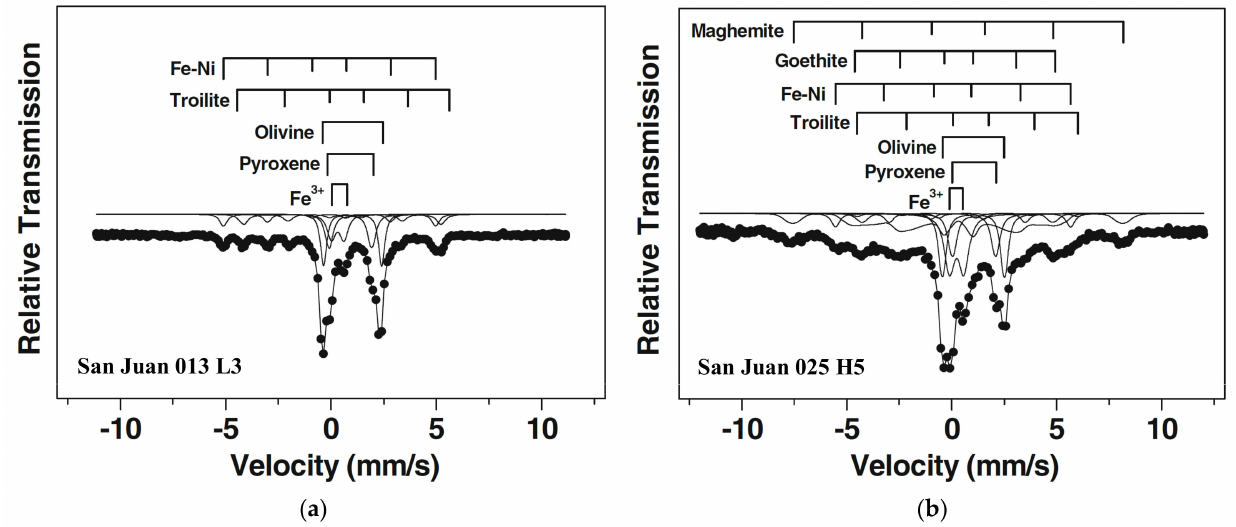
Figure 48. Mössbauer spectra of San Juan 013 L3 ( a ) and San Juan 025 H5 ( b ) ordinary chondrites with different weathering grade found in the Atacama Desert, Chile and measured at room temperature. Indicated components are the results of the spectra decomposition. Adapted from Reference